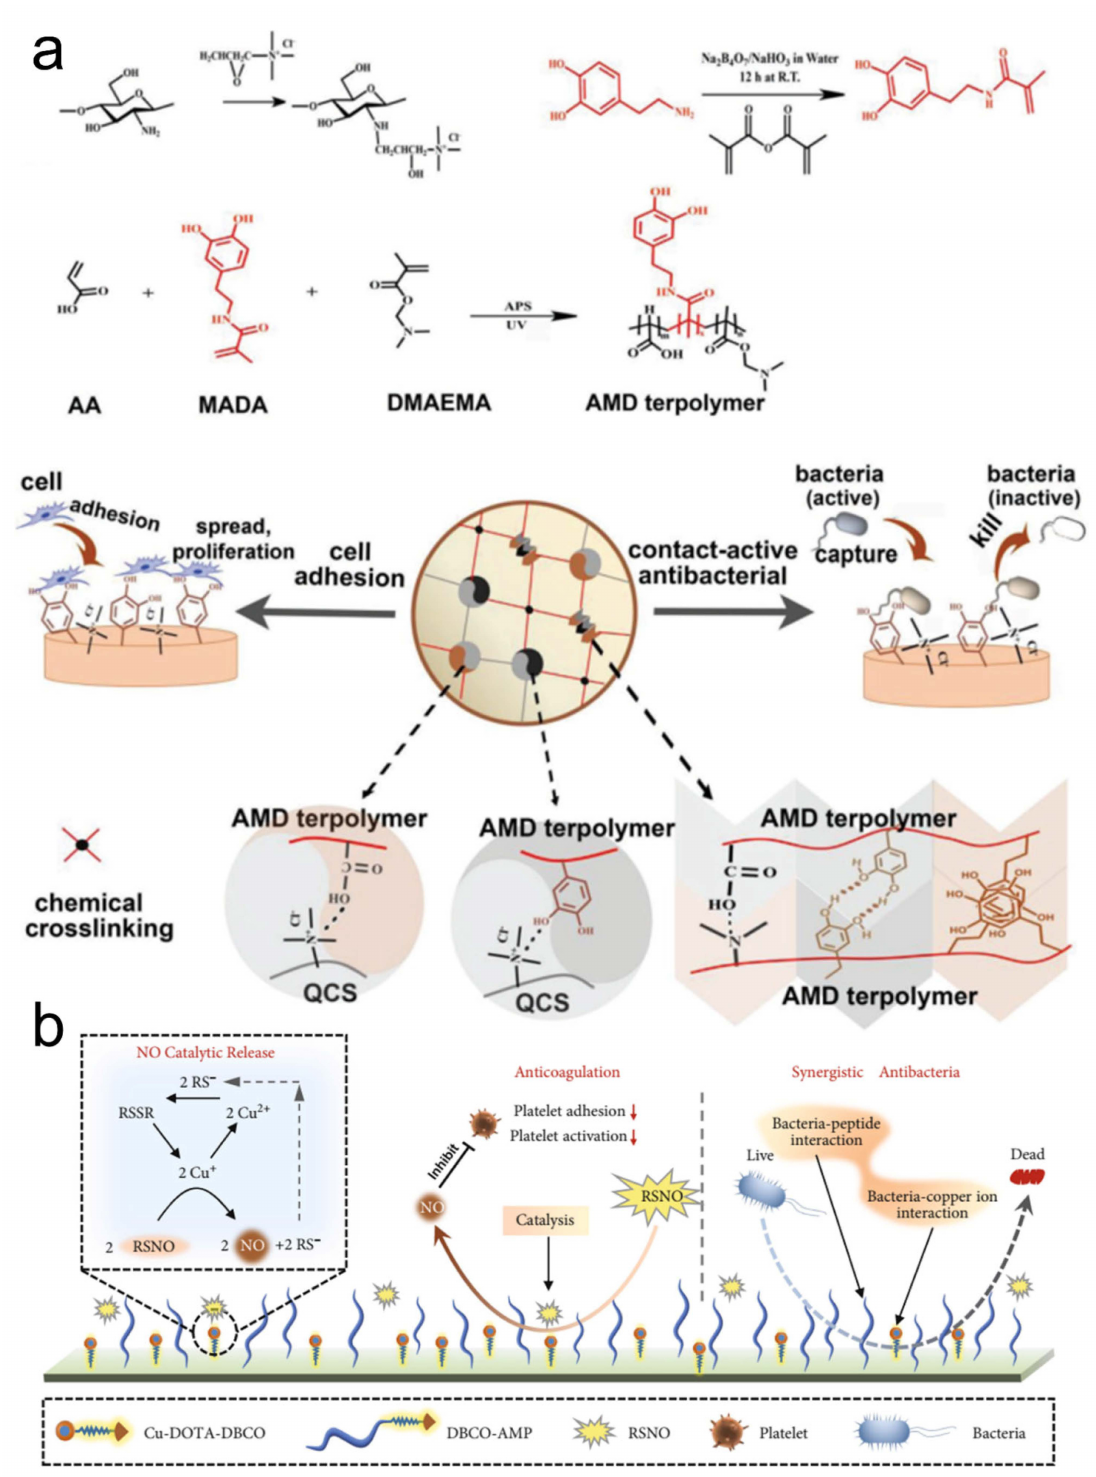
Figure 3. ( a ) A strong and tough hydrogel adhesive could promote the adhesion of fibroblasts, which was derived from the methacrylamide dopamine. The intrinsic antimicrobial properties originated from the quaternized chitosan molecules. Reproduced with permission [40]. Copyright 2019, John Wiley and Sons. ( b ) Realization of anticoagulation and synergistic antibacterial properties of Cu-DOTA&AMP